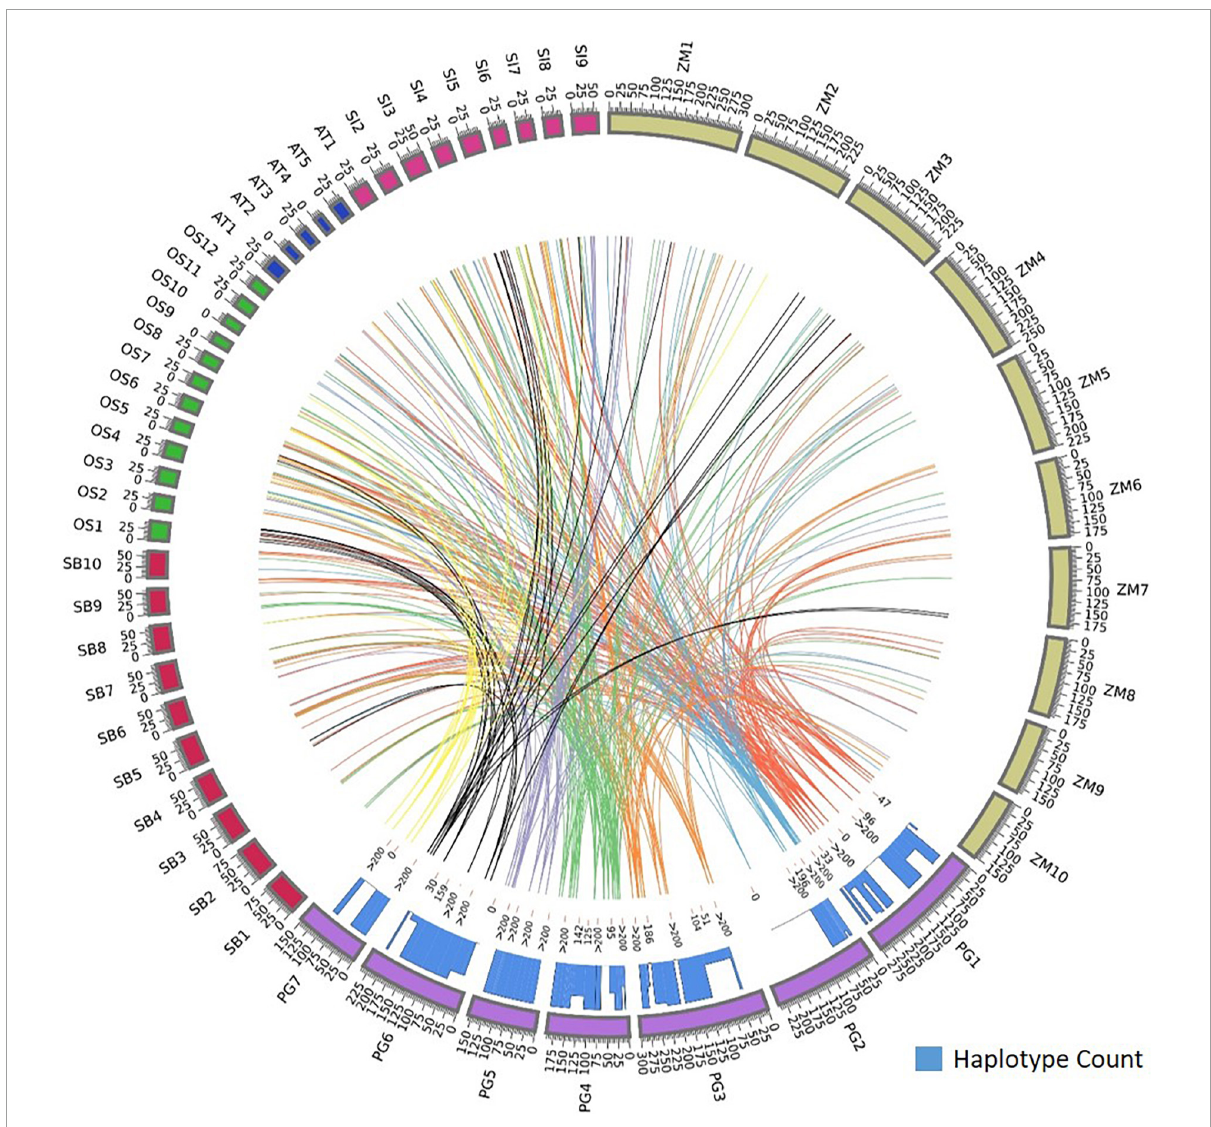
FIGURE4 Comparative map showing the orthologous genes of Fe and Zn homeostasis in pearl millet to rice, maize, sorghum, foxtail millet, and Arabidopsis spp. and the histogram within circos plot represents the haplotypes count of identified orthologous genes when aligned to pearl millet gene